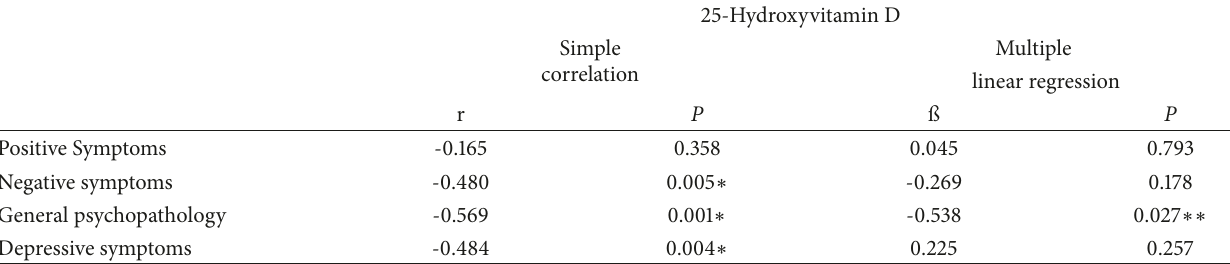
Table 2: Correlations between vitamin D levels and clinical variables in first-episode